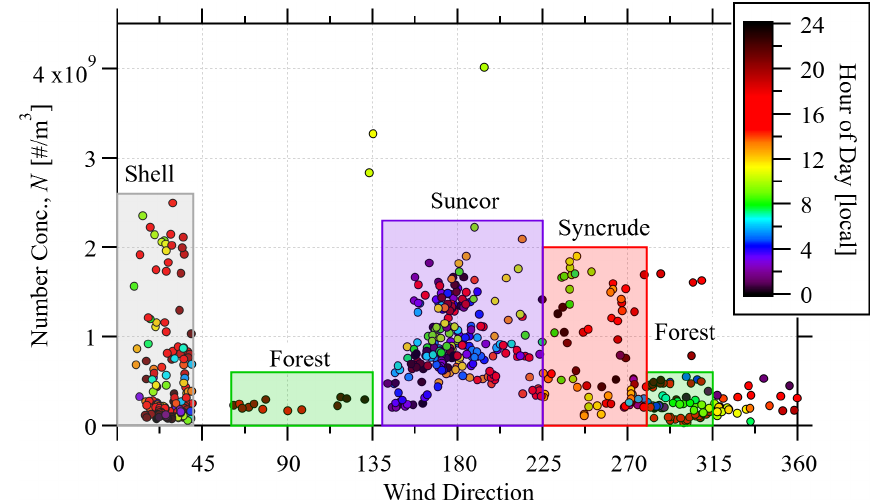
Figure 2. Total particle number concentration, N (60nm to 1µm), with wind direction as 30min averages. Markers are colored by the hour of day. To ensure consistent winds, only observations with less than 20 ◦ change in wind direction in the preceding and following 30min measurements are used. Four sets of measurements in wind direction–concentration space are identified for